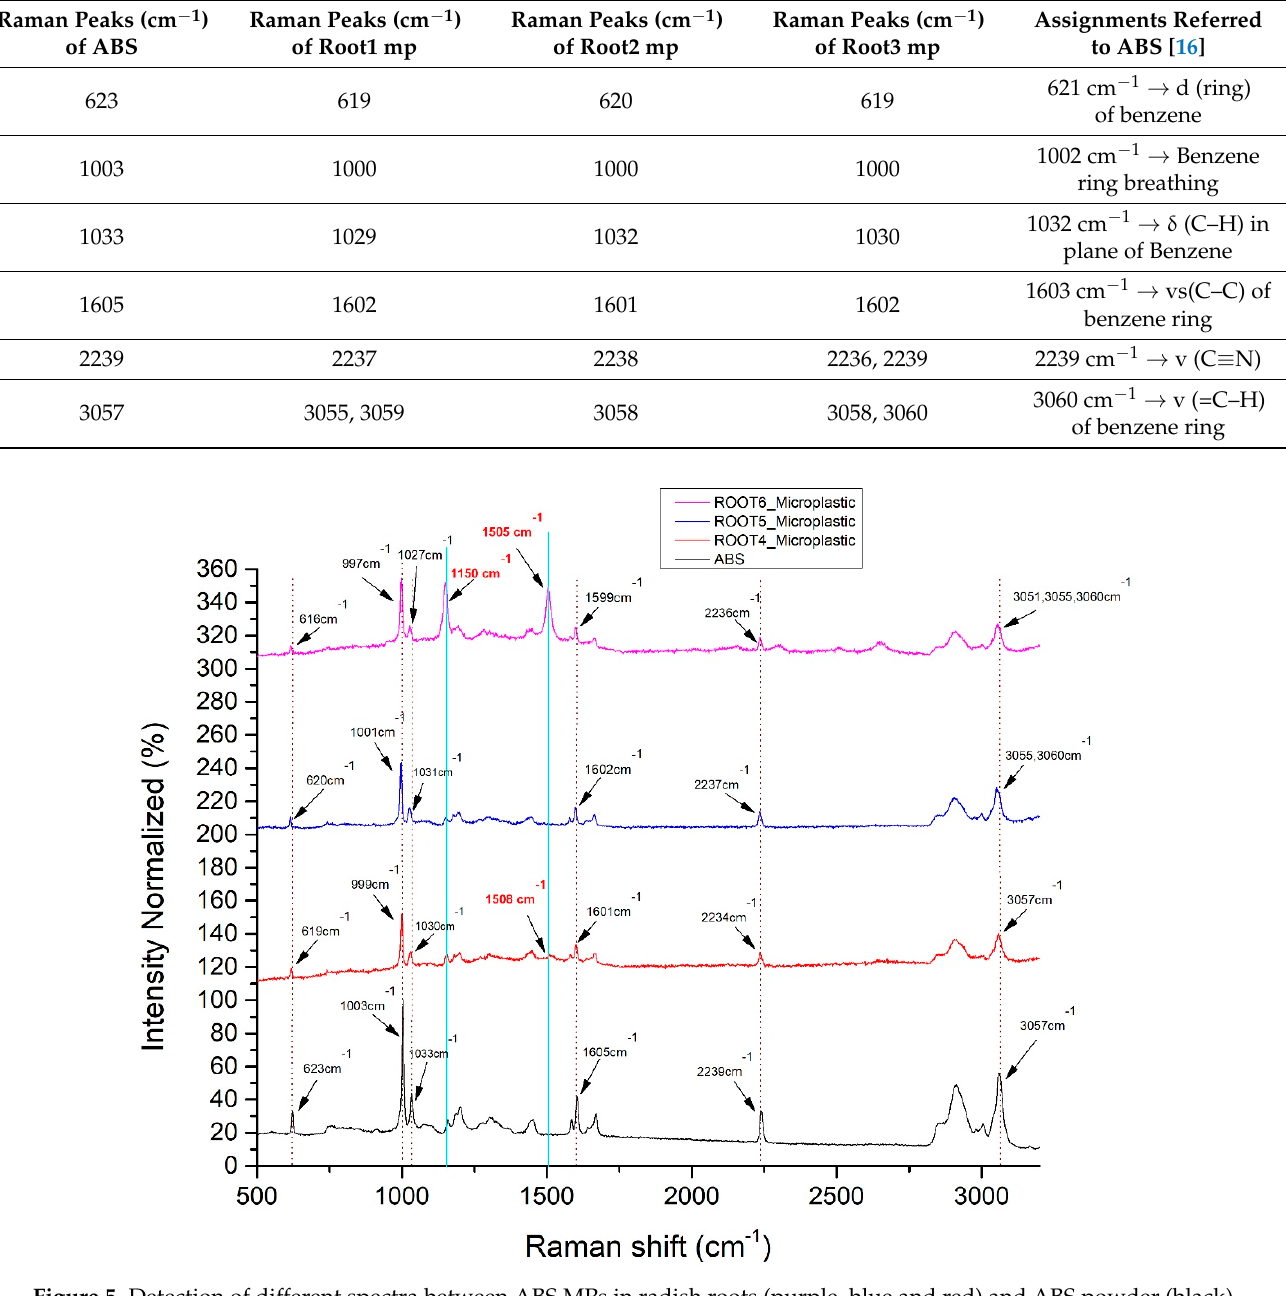
Table 2. Raman peaks of ABS and MPs with their assignments.